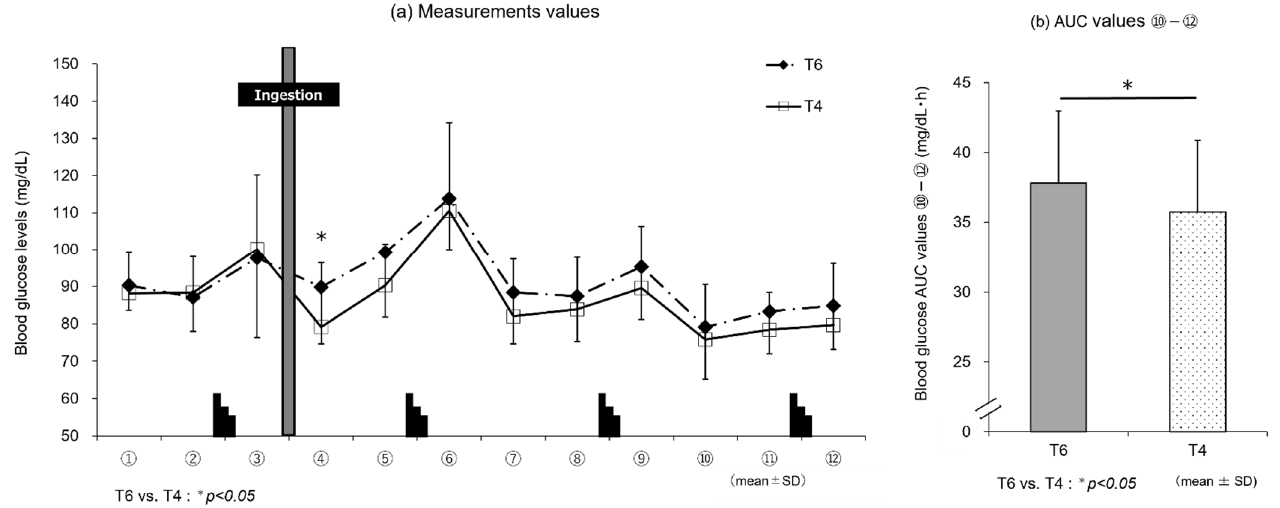
Figure 4. Changes in the blood glucose levels with trial drinks (experiment 2). Comparison between ( a ) measurements and ( b ) area under the curve (AUC) ⑩ – ⑫ values of trial drinks ( n = 10). T6 vs. T4: * p < 0.05. T6, 6% trehalose; T4, 4% trehalose.